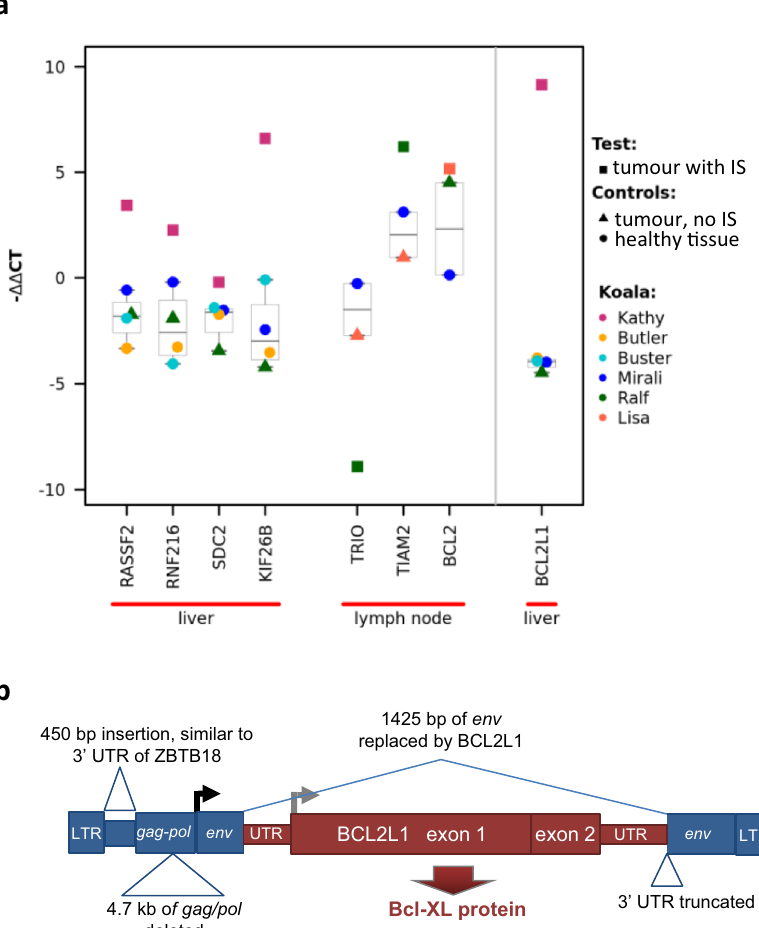
Fig. 2 qPCR expression of genes containing tumour-speci fi c KoRV IS and structure of KoRV containing transduced oncogene. a Expression of a set of genes containing tumour-speci fi c IS. Quantitative PCR expression levels ( ΔΔ Ct values 83 ) are shown, per gene, for tumour tissue from the individual with the tumour-speci fi c IS (square icon), and for tumour (triangles) or healthy tissues (circles) from other koalas (colour-coded). All qPCRs were performed in triplicate and the mean used for analysis. Boxplots indicate the interquartile range (IQR) with the centre line showing the median; whiskers show 1.5 × IQR. Two zoo koalas (Bilyarra and Mirali) not collected for the study of neoplasms were also used as controls, with Bilyarra used as a baseline for ΔΔ Ct values (i.e. for each gene all Δ Ct values were divided by that of Bilyarra, so Bilyarra does not appear in the graph). Genes with signi fi cant changes in expression were: RASSF2 ( P = 0.0023), RNF216 ( P = 0.0096), KIF26B ( P = 0.0015) and TIAM2 ( P = 0.0425) based on t tests of Δ Ct values. The expression of the transduced oncogene BCL2L1 ( Bcl-XL ) shown on the right side of the graph was also signi fi cantly increased ( P = 0.0004). The expression levels of BCL2L1 were 500-fold higher in Kathy than the other koalas tested (fold change calculated as 2 − ΔΔ Ct ). b Structure of the KoRV containing transduced BCL2L1 detected in Kathy. The two BCL2L1 exons are joined together precisely at the splice junction and are fl anked by the beginning and end of the KoRV env gene. The BCL2L1 3 ′ UTR joins the 5 ′ and 3 ′ ends of env via micro-homologies (CAG and CCTCCC, respectively). Most of gag and pol are also replaced by a sequence similar to the 3 ′ UTR of koala gene ZBTB18